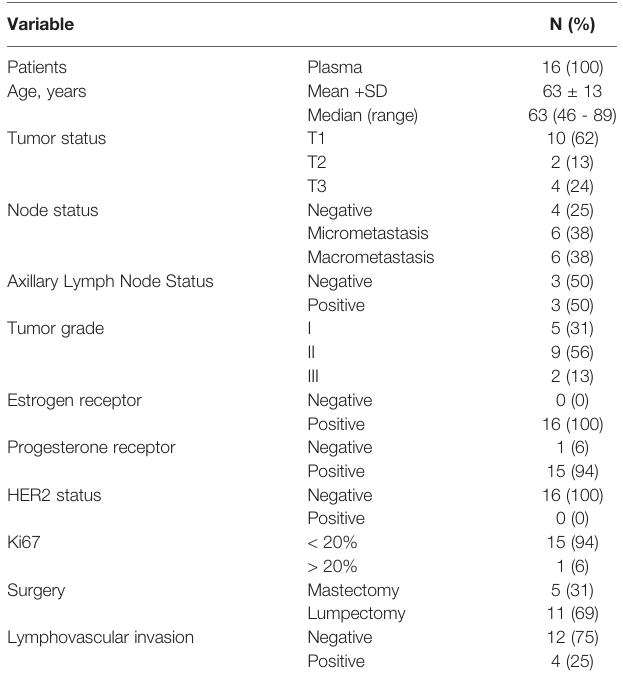
TABLE 1 | Basic patient and tumor